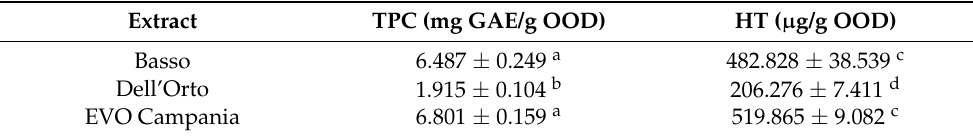
Table 1. Extraction yields (Method 1–acidified methanol).